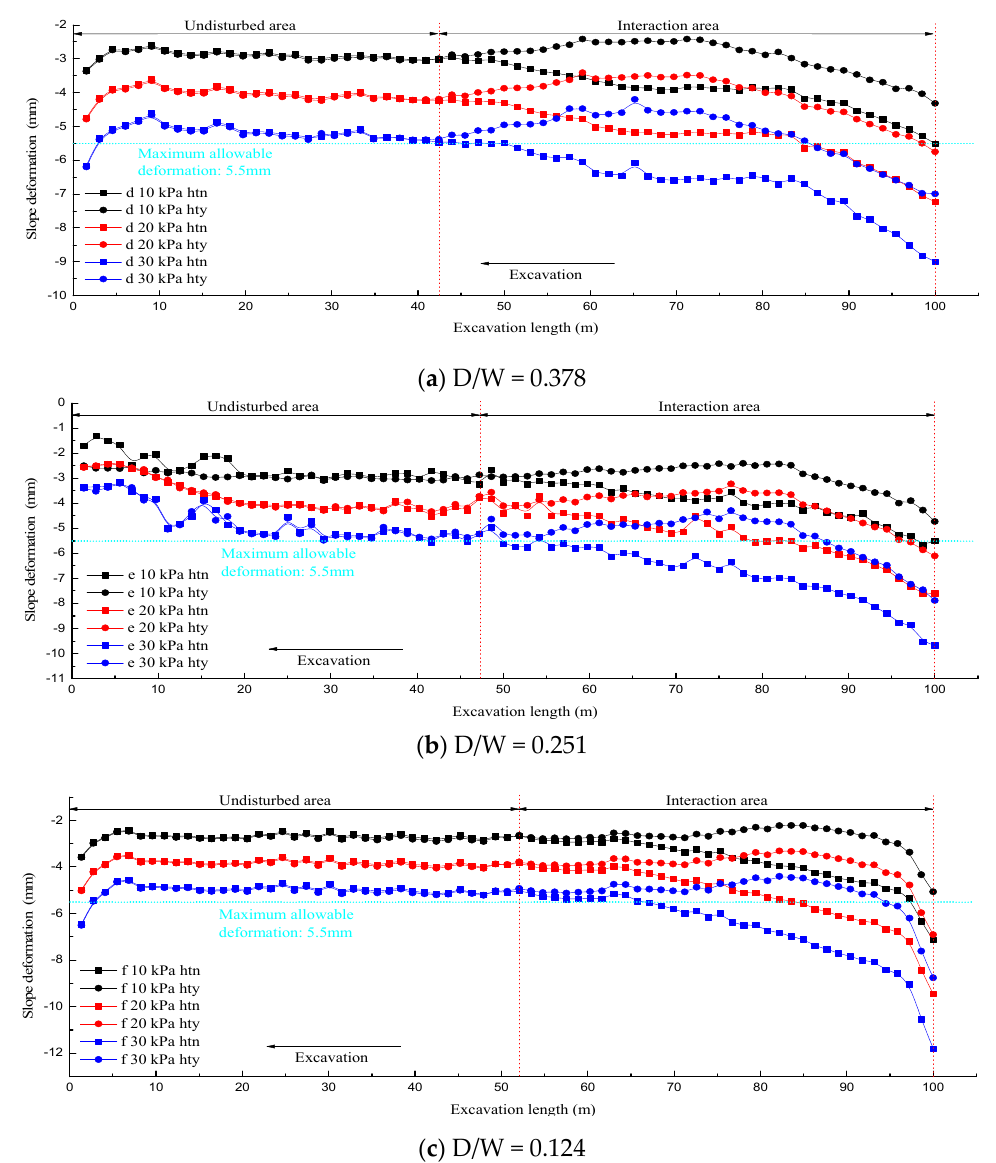
Figure 21. Longitudinal surface settlement of models D-D to F-F with C/H = 0.606.